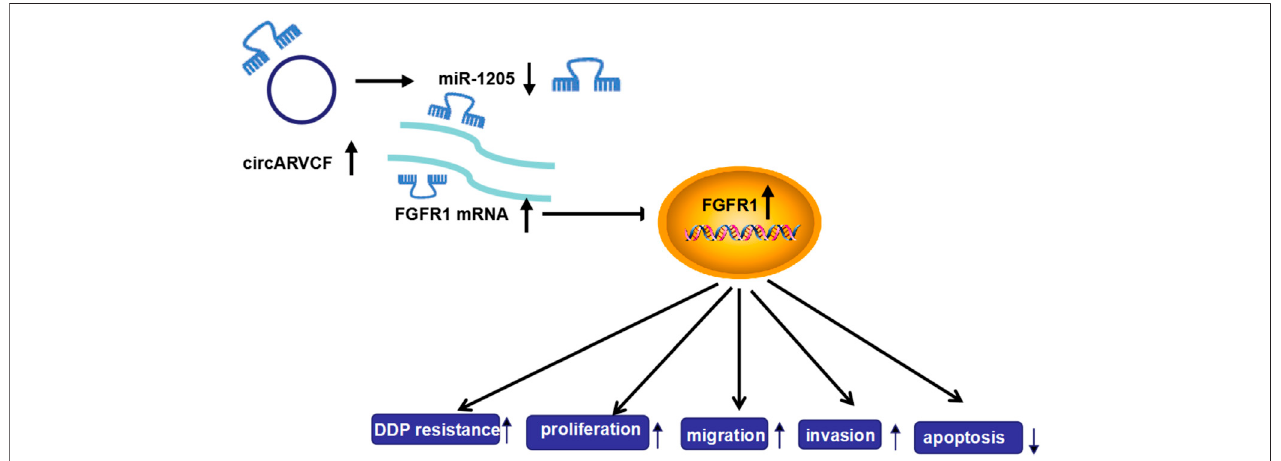
FIGURE 8 | The frame diagram of circARVCF/miR-1205/FGFR1 axis in regulating DDP resistance and cell progression in